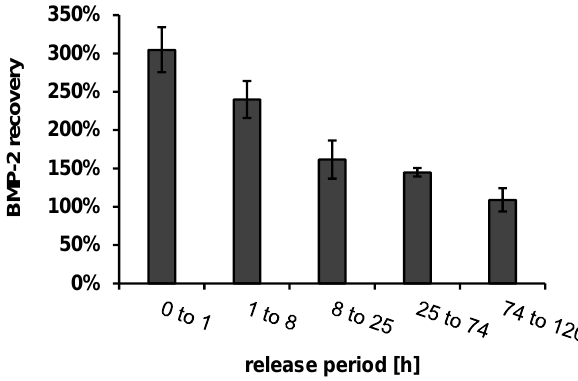
Figure 5. ELISA recovery of 330 ng mL −1 BMP-2 in release medium (PTB), containing dissolved components of the implant prototypes after extraction intervals, corresponding to the intervals of release experiments ( n = 3, error bars indicate SD).